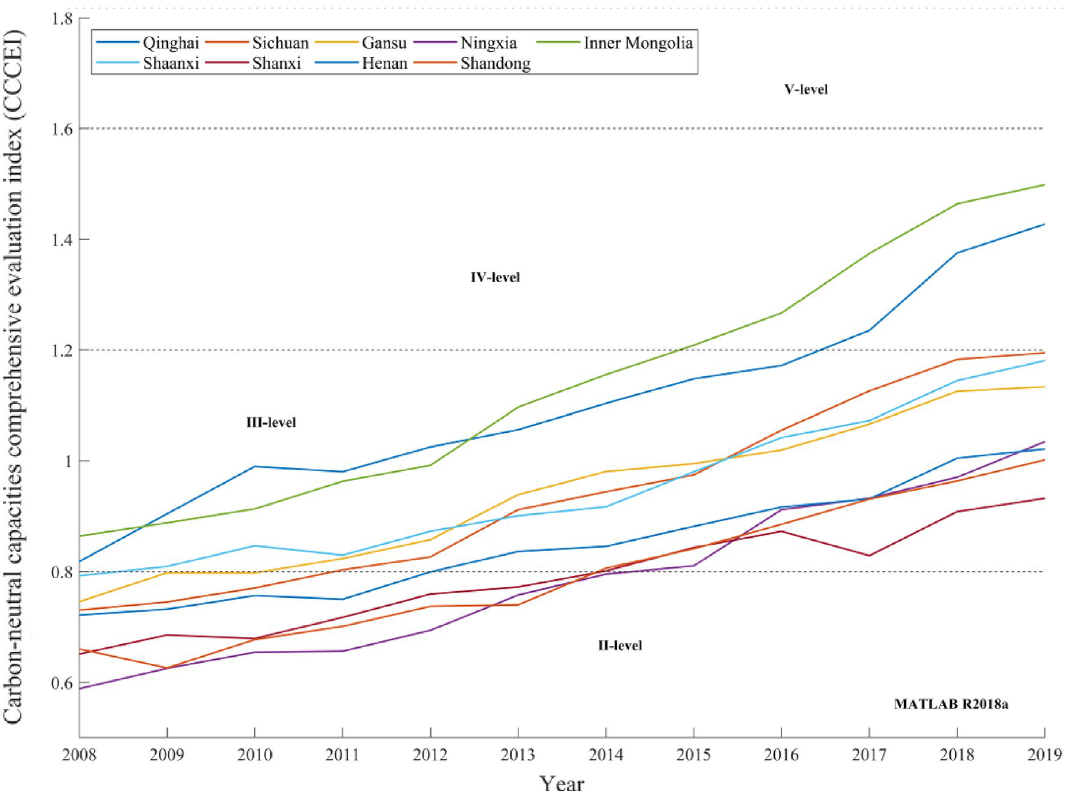
Figure 8. Provincial CCCEIs of the Yellow River basin from 2008 to